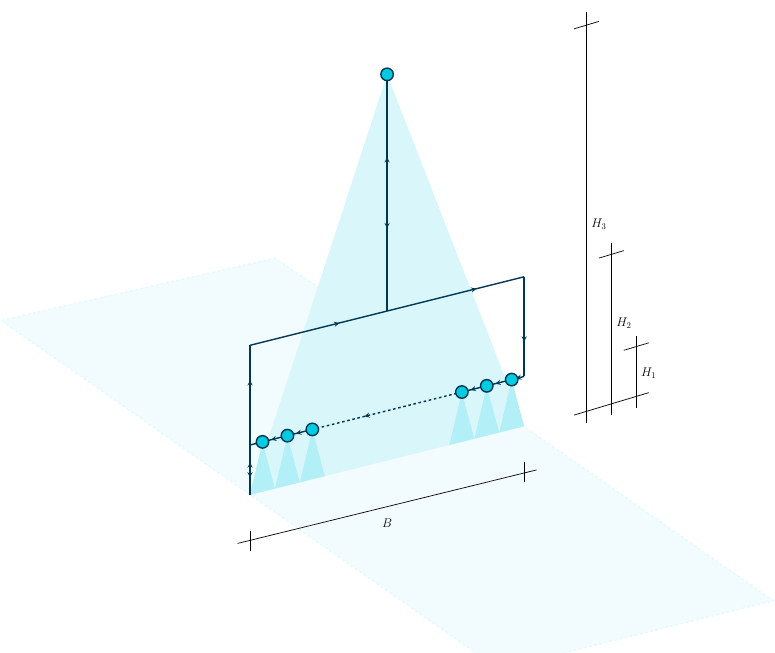
Figure 1. Overview of drone flight path used for the aerial survey. Under normal conditions, H 1 = 5 m, for quantitative plastic transport estimation and plastic classification, and H 2 = 15 m, for qualitatively indicating plastic transport “hot pots” along the river transect. H 3 is calculated based on the total river width, B